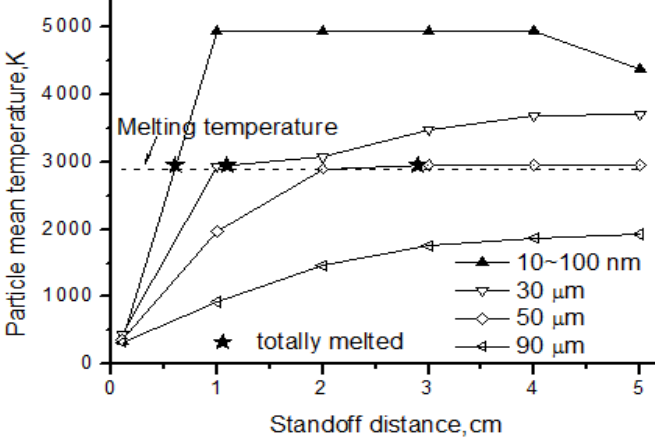
Figure 12. Temperature of nanoparticles and agglomerates.